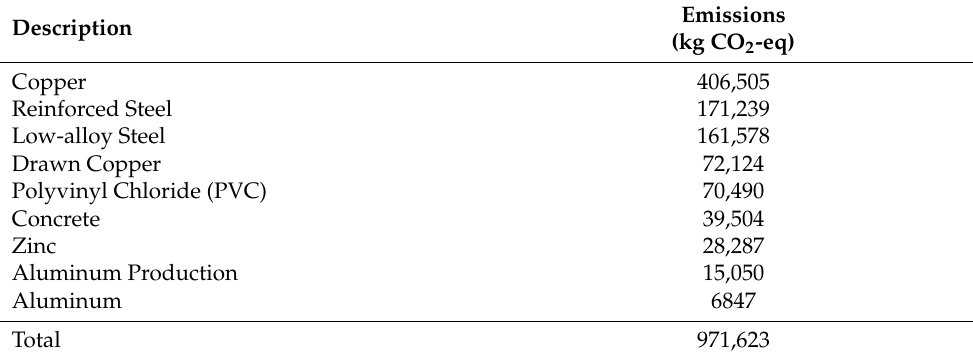
Table 6. GHG emissions related to support structure and cabling.